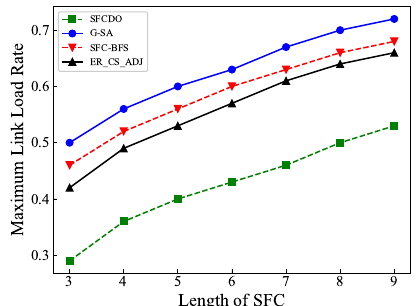
Figure 11. Maximum link load rate of SFCs in small topology.